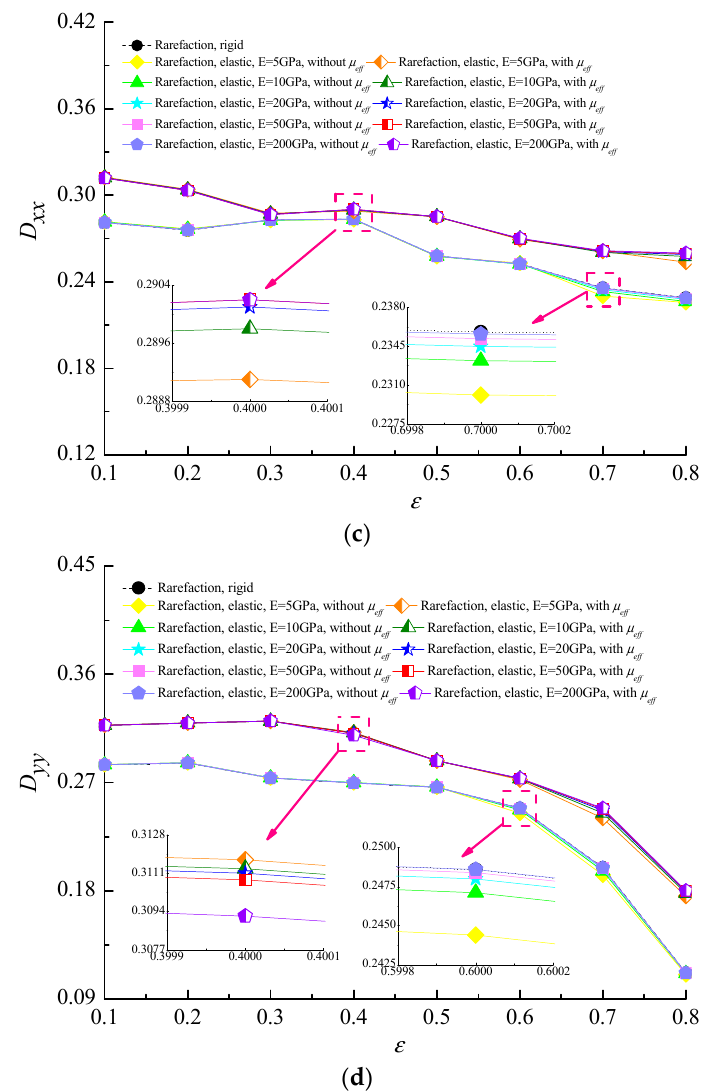
Figure 10. Effect of eccentricity ratio on dynamic stiffness and damping coefficients for variable and constant viscosity of lubricant with different elastic moduli. ( a ) K xx vs. ε ; ( b ) K yy vs. ε ; ( c ) D xx vs. ε ; ( d ) D yy vs. ε ( Ω = 3.5, Λ = 80, υ = 0.3).